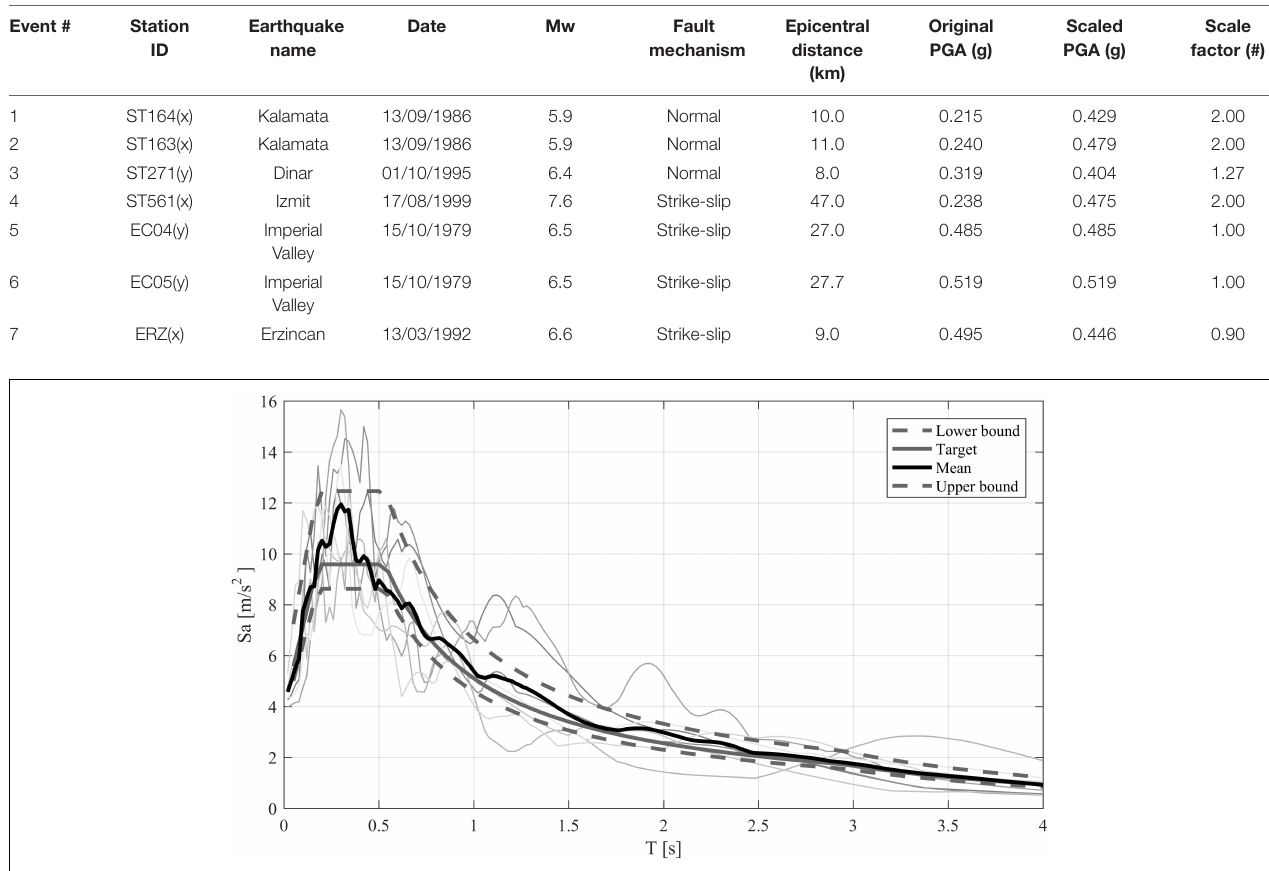
FIGURE 2 | Spectrum-compatibility graphical results.